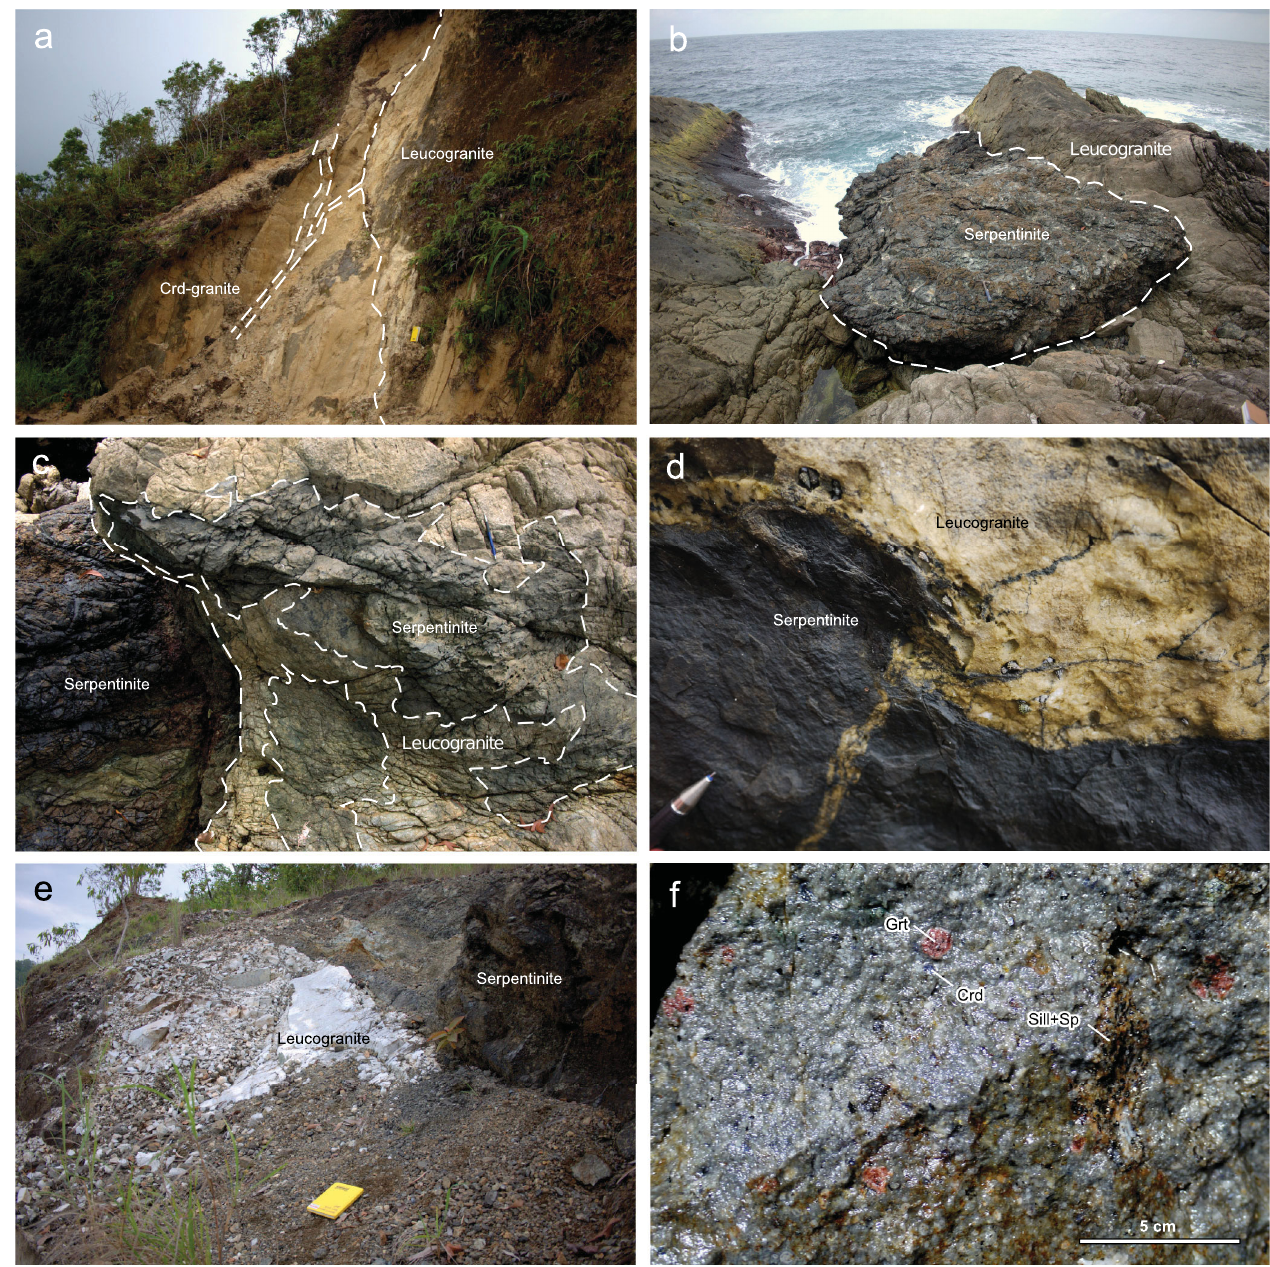
Fig. 19. Field relations on Ambon. (a) Leucogranite intruding cordierite granites, central Latimor (128.2174 ◦ E, 3.7171 ◦ S); (b) Fragment of serpentinite breccia thrust over chloritised leucogranites on Tanjung Seri, southern Latimor (128.1865 ◦ E, 3.7479 ◦ S); (c) Contact be- tween serpentinite and leucogranite just east of Tanjung Seri along which large xenoliths of serpentinite are included in the leucogranite (128.1866 ◦ E, 3.7479 ◦ S); (d) Serpentinite back-veined into leucogranite masking the original intrusion of leucogranite into peridotite, east of Tandjung Seri (128.1866 ◦ E, 3.7479 ◦ S); (e) Wide leucogranite dyke intruded through serpentinised peridotites, south Latimor (128.2600 ◦ E, 3.7295 ◦ S); (f) Ambonite containing large cordierite and garnet xenocrysts and spinel+sillimanite xenoliths, from northern Hitu (128.0640 ◦ E, 3.5930 ◦